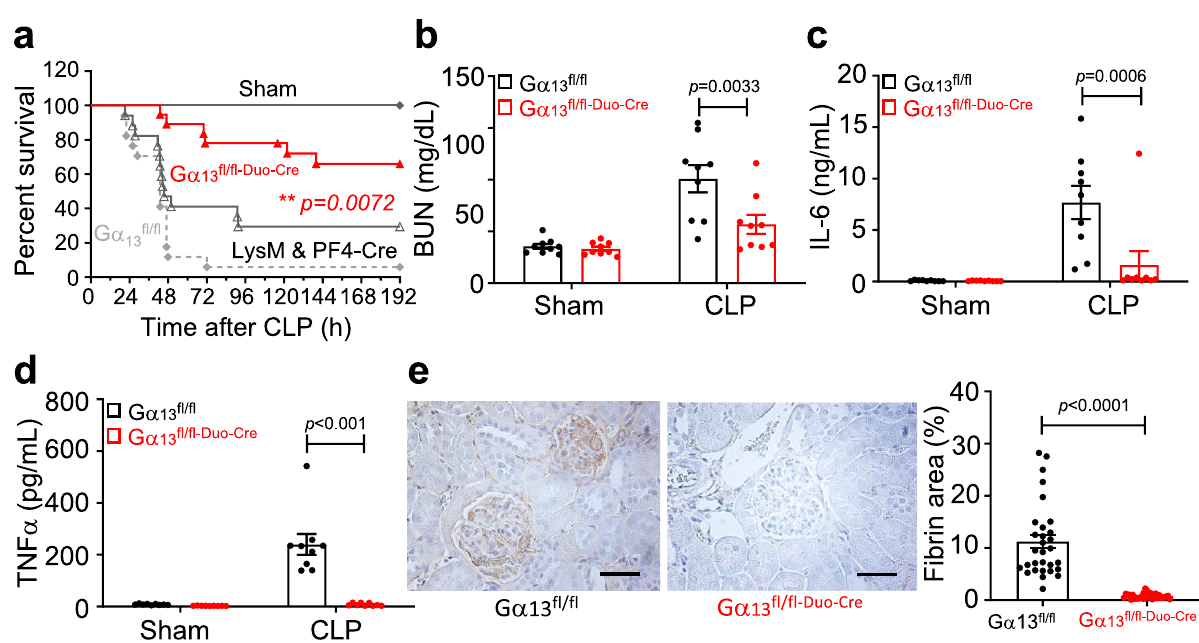
Fig. 8 Platelet and Leukocyte dual-speci fi c G α 13 knockout reduces in fl ammatory cytokines, thrombosis, and renal injury and improves survival in a mouse CLP sepsis model. a Survival rate in mice after CLP-induced sepsis in G α 13 fl / fl -PF4/LysMCre mice compared to LysM & PF4-double Cre or G α 13 fl / fl control miceDouble Cre sham, n = 6; double Cre CLP, n = 16; G α 13 fl / fl CLP, n = 17; G α 13 fl / fl -PF4/LysMCre sham, n = 7; G α 13 fl / fl -LysMCre CLP, n = 19 (all groups, independent animals). Log-rank (Mantel – Cox) test (two-tailed). b Plasma levels of BUN in septic mice 24 h after CLP in G α 13 fl / fl -PF4/LysMCre mice compared to G α 13 fl / fl mice. All groups, n = 9. c , d Serum levels of IL-6 and TNF α in septic mice 24 h after CLP in G α 13 fl / fl -PF4/LysMCre mice compared with G α 13 fl / fl control mice. All groups, n = 9. e Images and quanti fi cation of immunohistochemical staining of fi brin deposition in mouse kidney 24 h after CLP. Bar graph shows the percentage of fi brin-positive stained area per glomerulus (30 random glomeruli from 6 mice/group, all groups, n = 30, independent glomeruli). Scale bar = 100 μ m. All data are shown as mean ± SEM. Data in ( b – d ) were analyzed by two-way ANOVA with Tukey ’ s multiple comparisons test; data in ( e ) were analyzed by a two-tailed Mann – Whitney